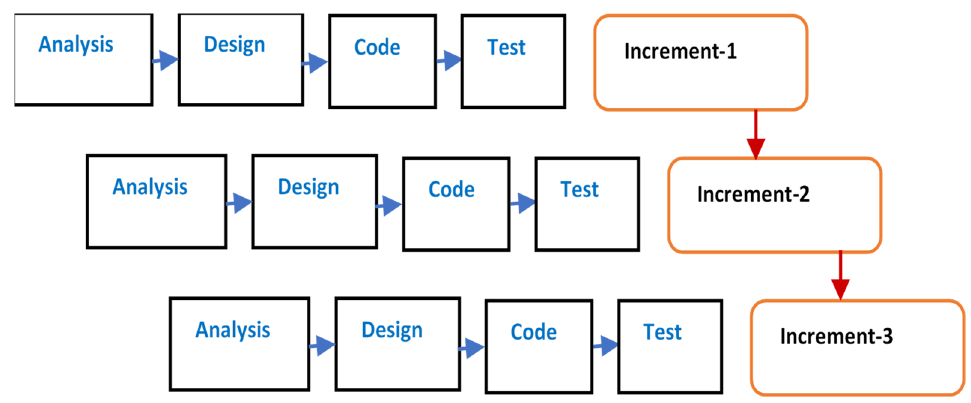
Figure 2. Incremental developmental model.